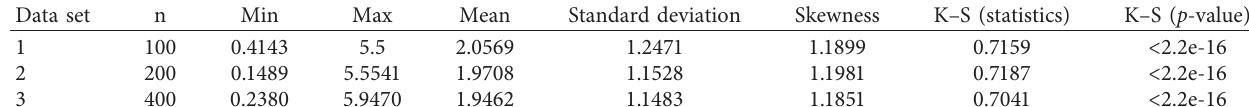
Table 1: Descriptive statistics for the simulated data from Model (II).